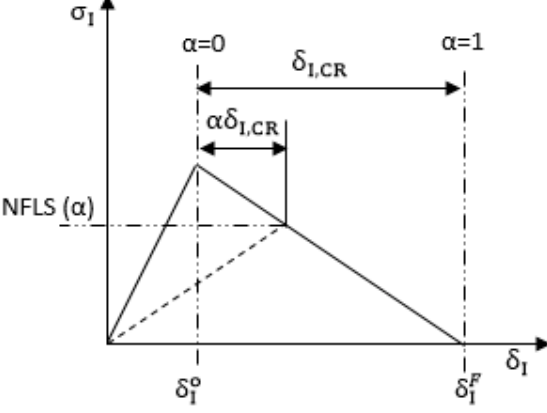
Figure 18. Parameters in the softening model [56].